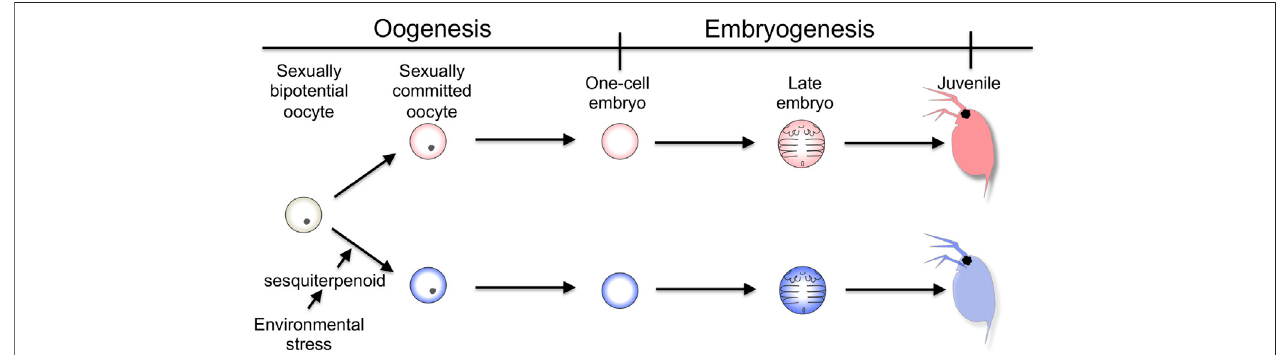
FIGURE 1 | Timing of sexual commitment in environmental sex determination of D. magna . Under the healthy condition, the sexually bipotential oocyte is committed to be developed into a female. In contrast, by the mother, the information of environmental decline is detected and converted into sesquiterpenoid signaling, which commits the sexual fate of the oocyte to male.